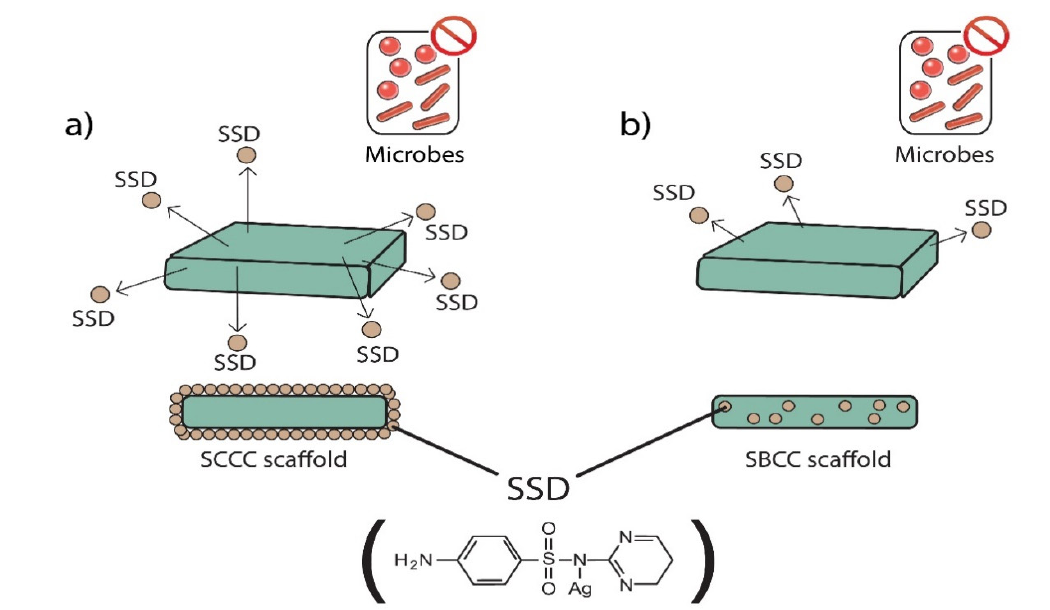
Figure 9. Schematic represents the releasing rate of silver ion from ( a ) SCCC scaffolds which rapidly release SSD and ( b ) the slow release of silver ion impregnated in the SBCC scaffolds.